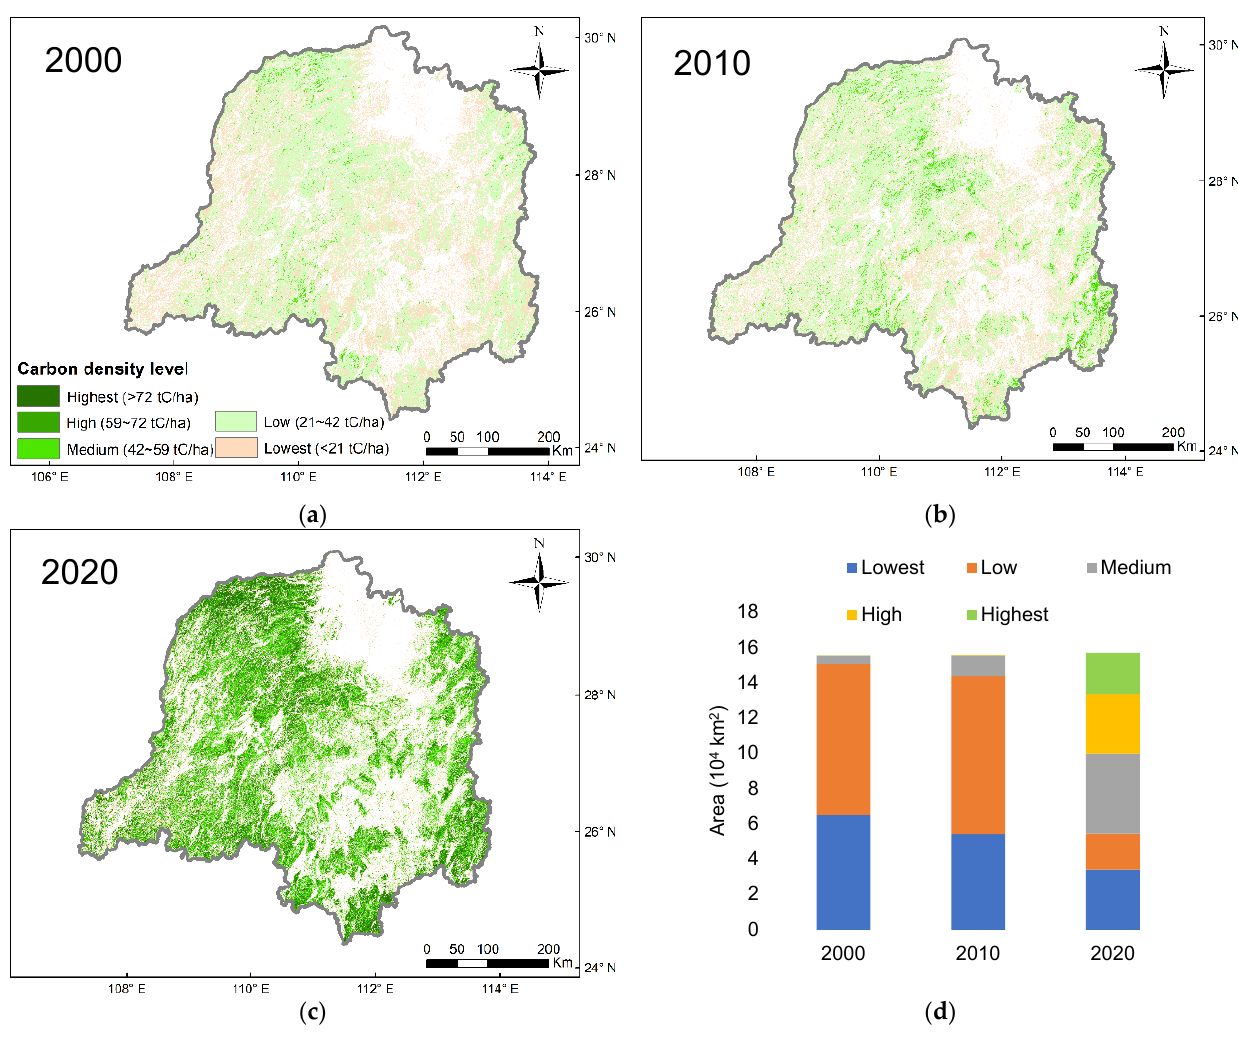
Figure 4. Biomass carbon density change of forest and shrub.